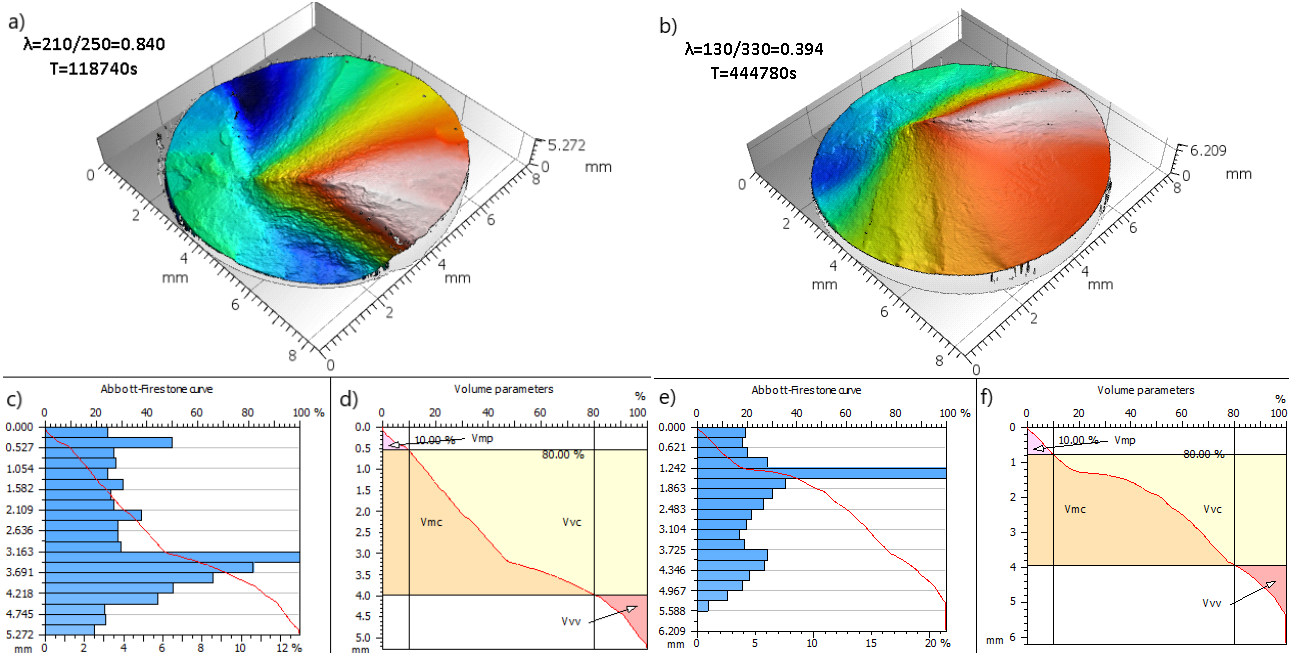
Figure 11. Fractures maximal Vv values for rupture area: ( a , b ) an isometric view of the entire fractures; ( c , e ) Abbott–Firestone curves; and ( d , f ) functional volume parameters plots.